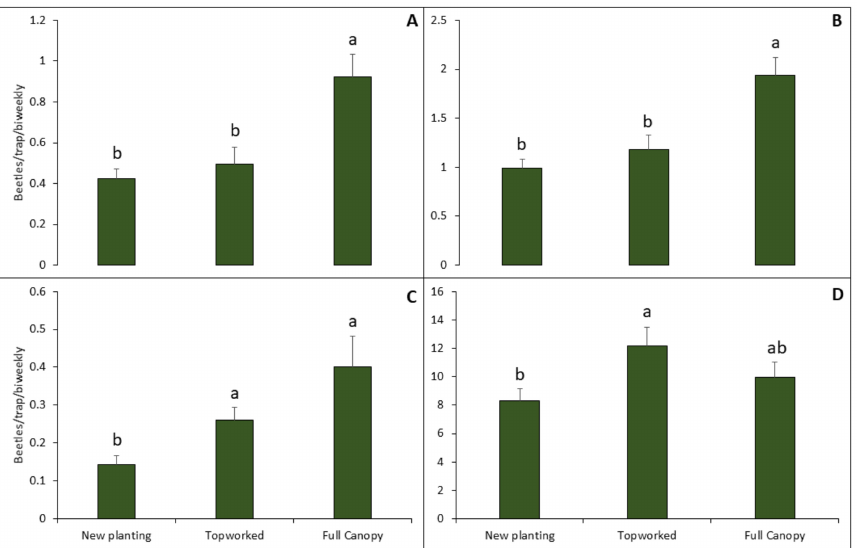
Figure 3. Average ( ± SEM) captures of LW vectors in three commercial avocado orchards (pooled) with laurel wilt over a one-year period. ( A ) Xyleborus affinis , ( B ) Xyleborus volvulus , ( C ) Xyleborus bispinatus , and ( D ) Xyleborinus saxesenii . Error bars with the same letters are not significantly different (Tukey HSD; α = 0.05). (Note different scales on the